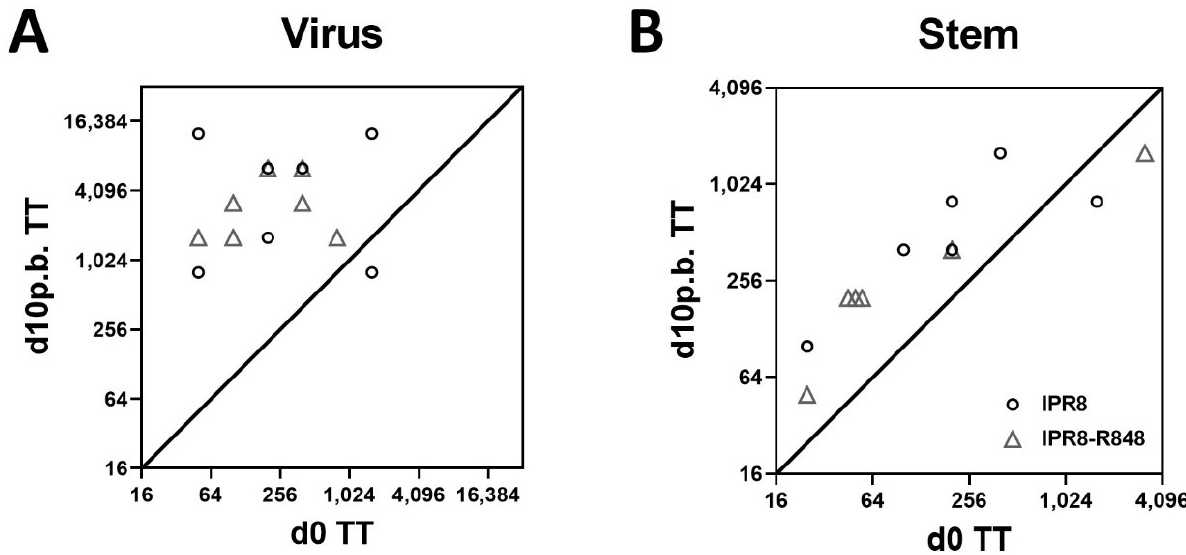
Figure 2. Elderly AGM generates HA-stem-specific IgG in response to vaccination. The levels of circulating IgG were quantified from the plasma of IPR8 (circles)- and IPR8-R848 (triangles)-vaccinated AGM. The d0 threshold titer (TT) for each animal was plotted against the d10 p.b. threshold titer. IgG specific to PR8 ( A ) or Ca09 trimeric stem protein ( B ) was measured. TT is defined by the highest dilution at which the sample’s optical density was at least 3 times that of the assay background.